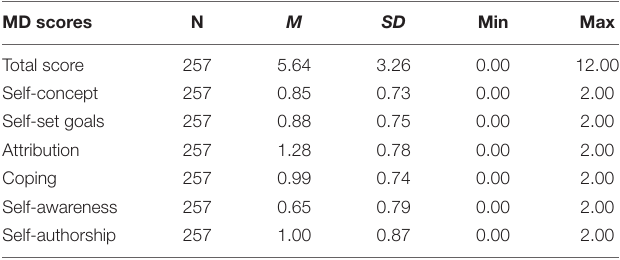
TABLE 1 | Descriptive statistics for the motivational and developmental (MD) total score and attribute scores across prompts.